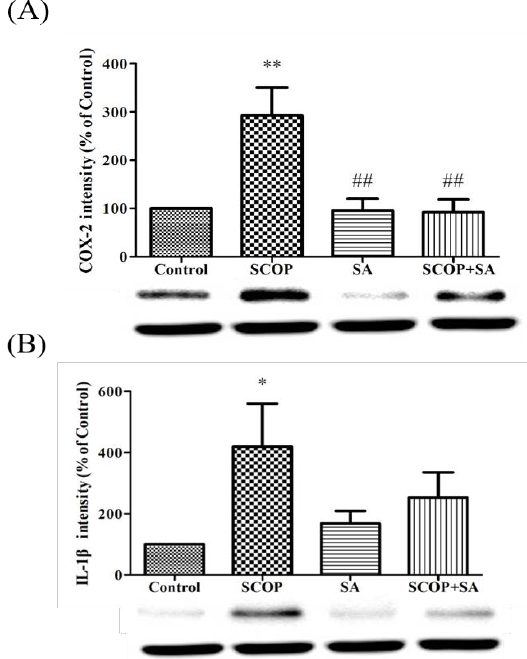
Figure 8. The effect of SA on the protein expression of COX-2 and IL- 1β in SCOP -induced rat by western blot. ( A ) Representative image of immunoblotting and band quantification of COX- 2/GAPDH. ( B ) Representative image of immunoblotting and band quantification of IL-1 β /GAPDH. All data showed as mean ± SEM. n = 4. * p < 0.05, ** p < 0.01 vs. the control group. ## p < 0.01 vs. the SCOP group. Analyzed by one-way ANOVA with LSD test.